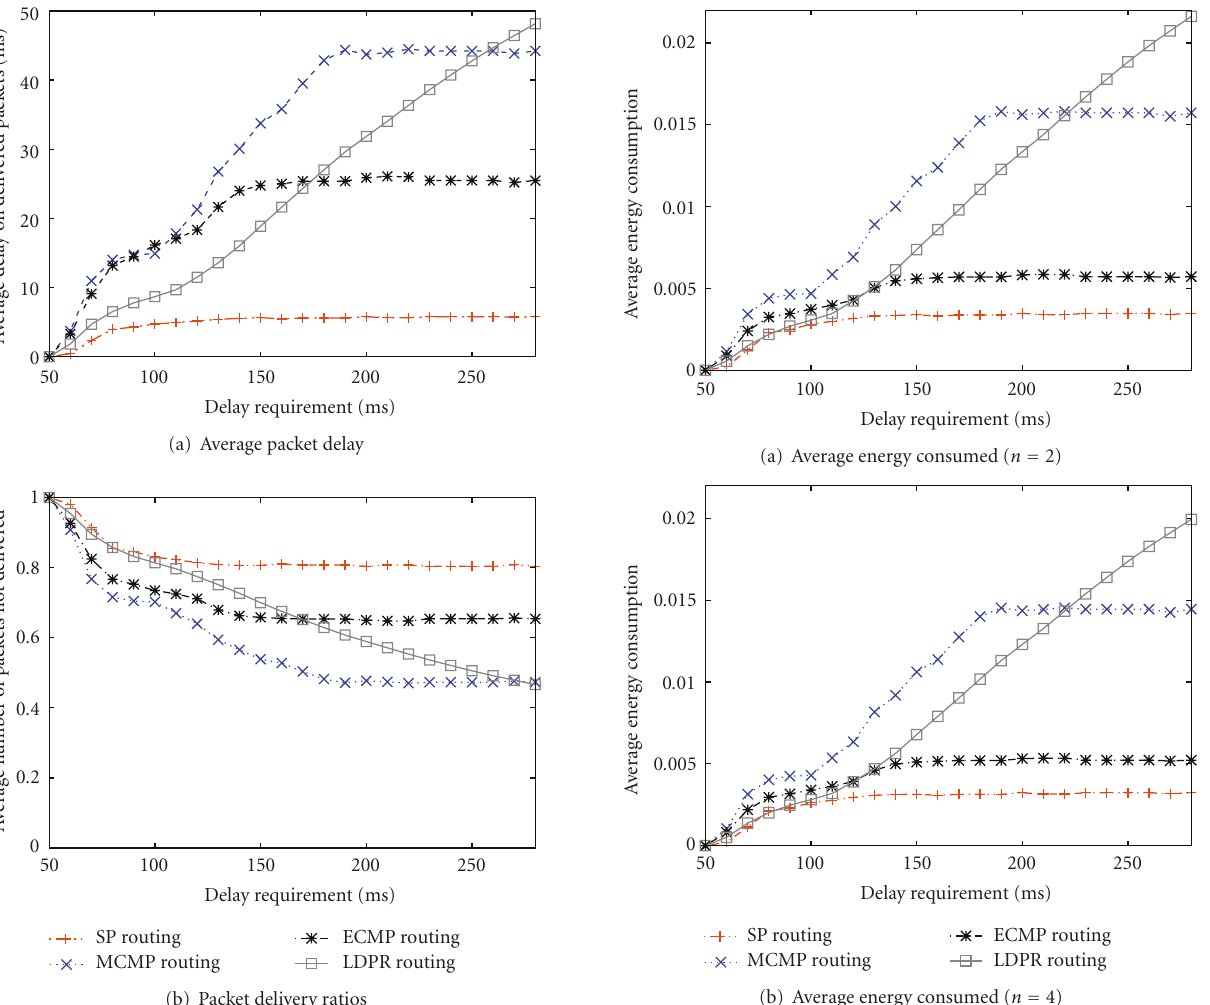
Figure 3: Comparing delay and packet delivery. Figure 4: Comparing the energy